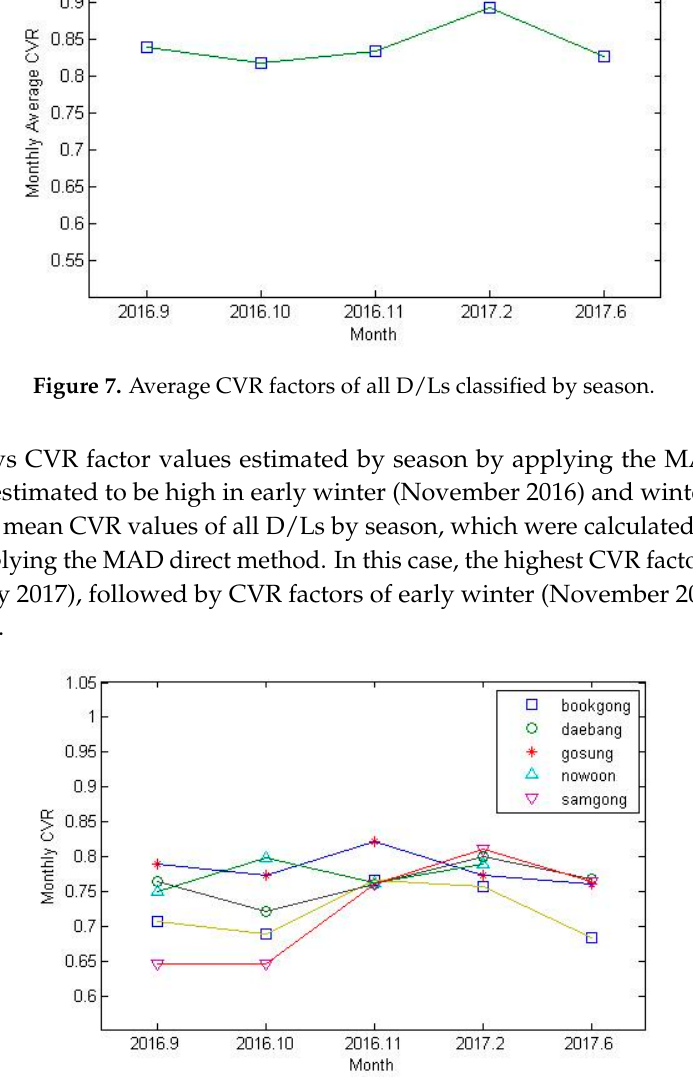
Figure 8. CVR factors estimated by applying the MAD direct method, classified by season.